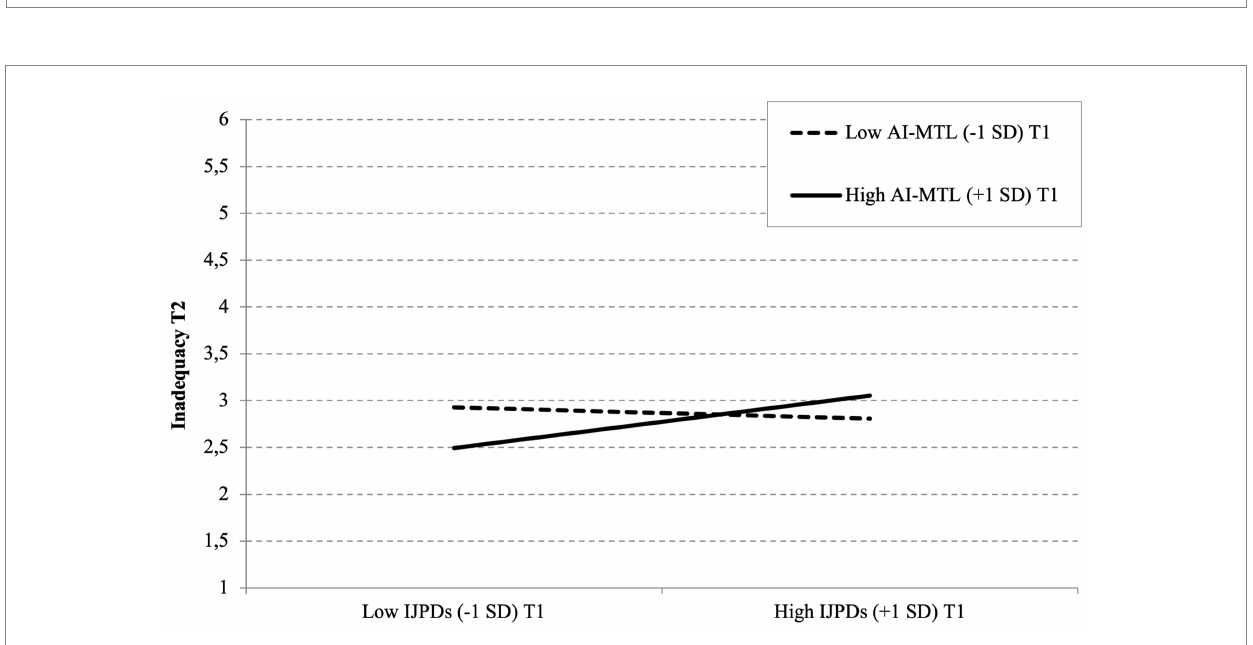
FIGURE 2 Two-way interaction effect between affective-identity motivation to lead (AI-MTL) at T1 and intensified job-related planning demands (IJPDs) at T1 on inadequacy at T2 ( B coefficients are reported in the text).